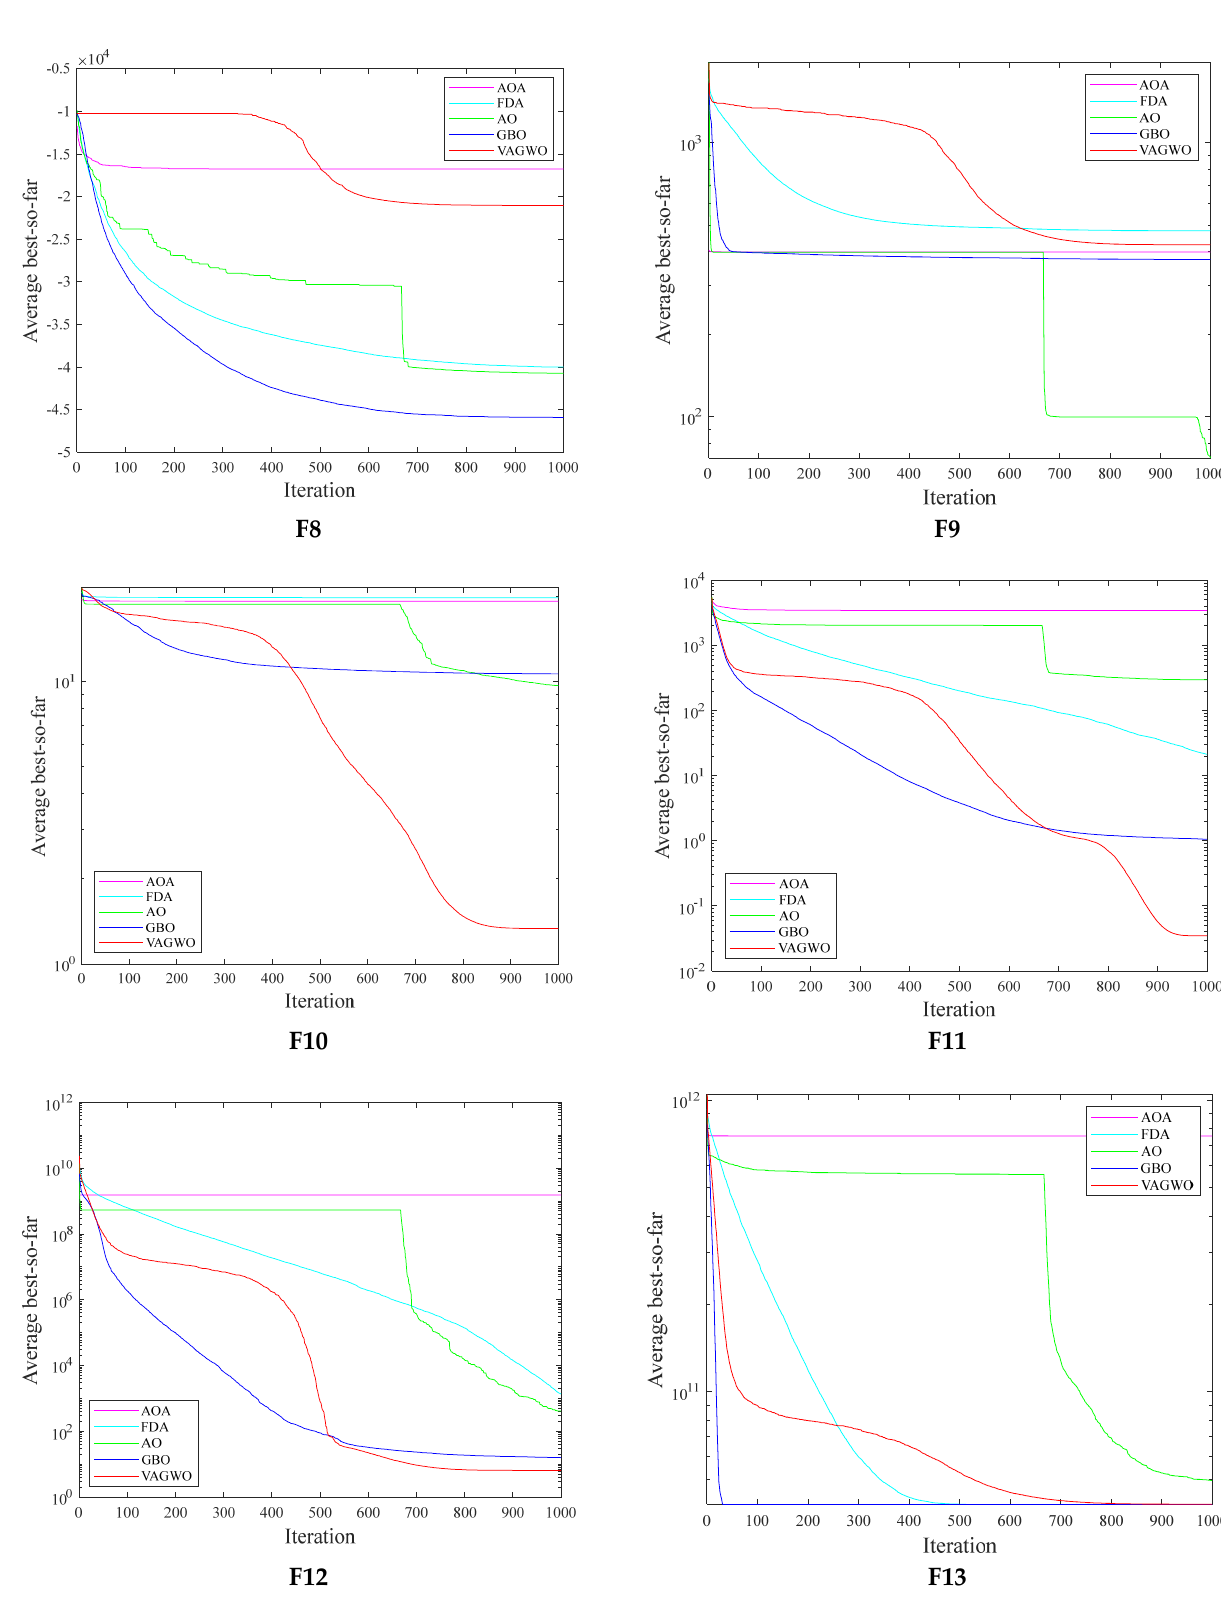
Figure 6. The convergence curves of the VAGWO and the newly proposed algorithms for F8–F13.